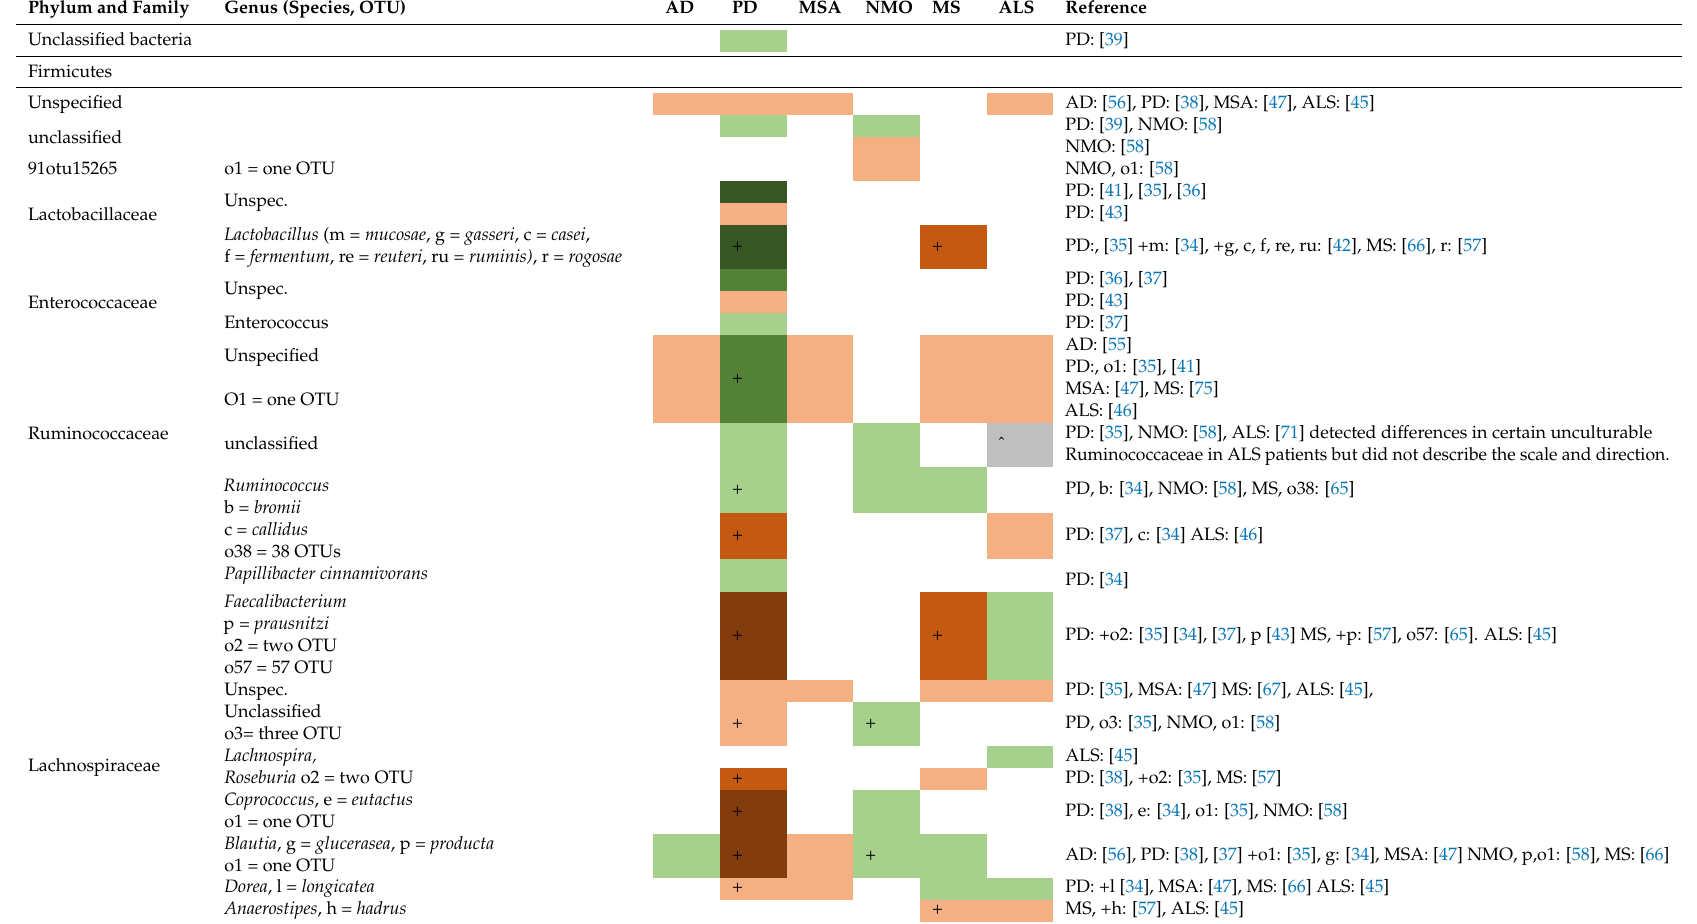
Table A1. Changes in relative abundances in neurodegenerative